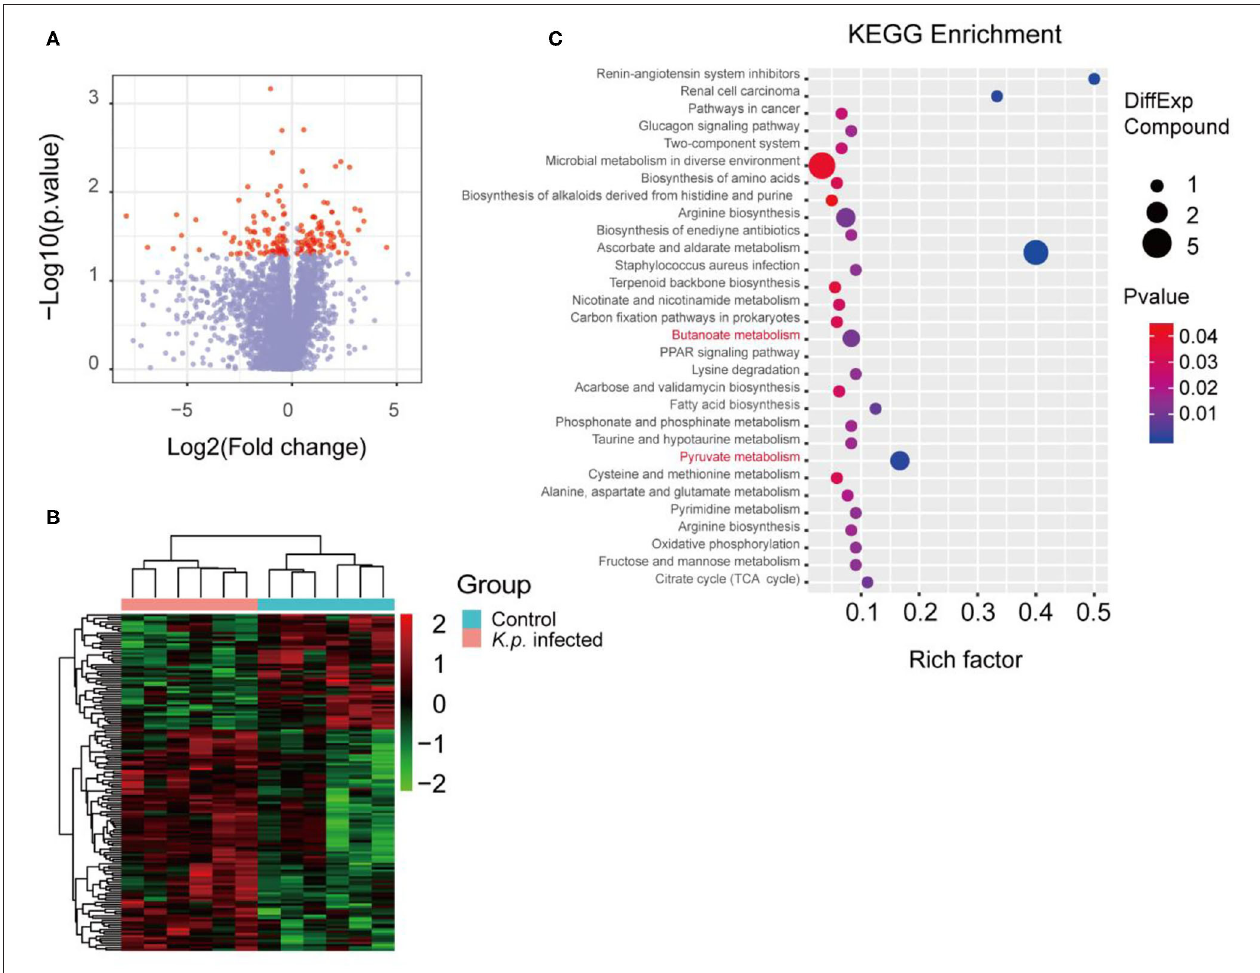
FIGURE 1 | Metabolomic profiles of cecal contents in K. pneumoniae -infected mice and healthy controls. (A) Volcano plot for analyses of host-produced metabolites in cecal contents from K. pneumoniae- infected mice and untreated controls. Fold change ≥ 1.5 or ≤ 0.5 and p < 0.05 are marked in red, and the rest are in blue. (B) Hierarchical clustering heatmap of host-produced metabolites in cecal contents of K. pneumoniae- infected mice and untreated controls. Red denotes increased expression, while green denotes decreased expression. (C) Selected examples of KEGG pathway enrichment. Disturbances in SCFA metabolism are highlighted in red. Group size is 8–10 per group. P- values are determined using two-tailed Student’s t -tests (A) or the Hypergeometric test and Benjamini–Hochberg FDR correction (C)